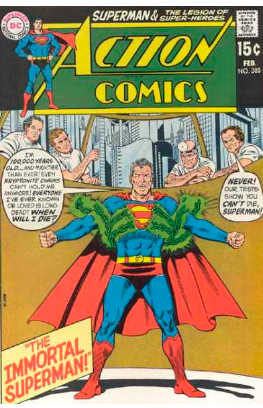
Figure 6. Action Comics #385, “The Immortal Superman!” (February 1970) [10].